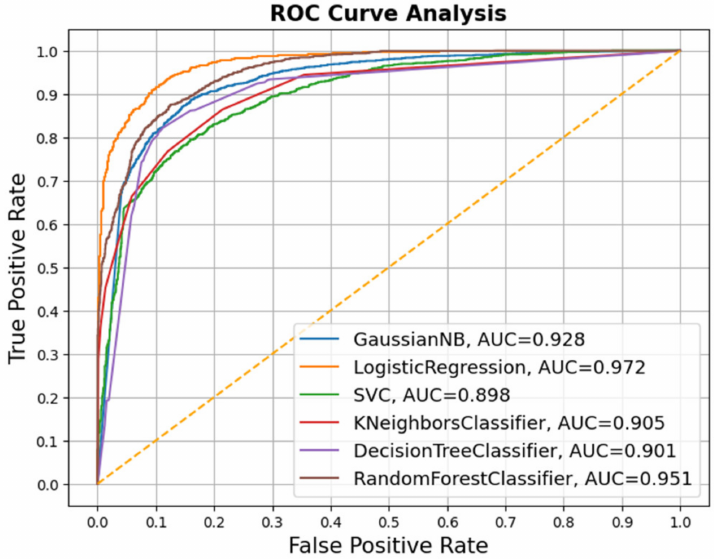
Figure 5. ROC curves of ML classifiers on Constraint@AAAI 2021